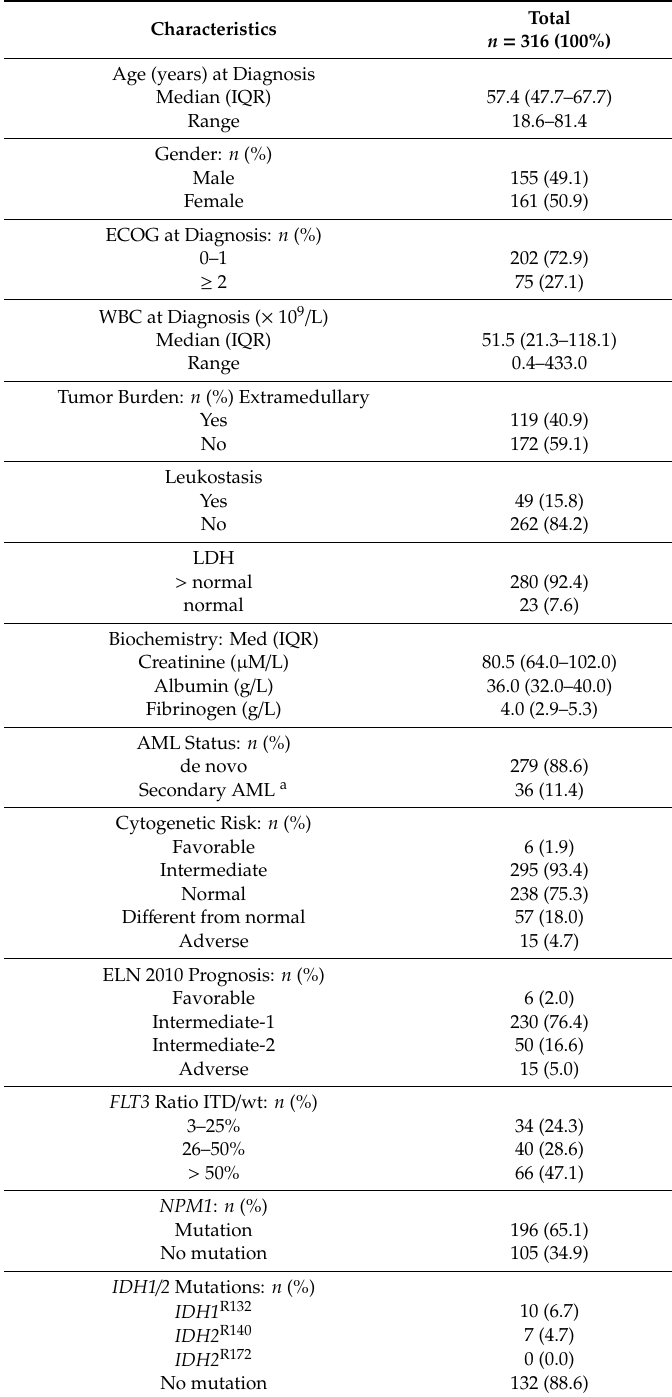
Table 1. Baseline characteristics of 316 newly diagnosed intensively treated FLT3 -internal tandem duplication (ITD) acute myeloid leukemia